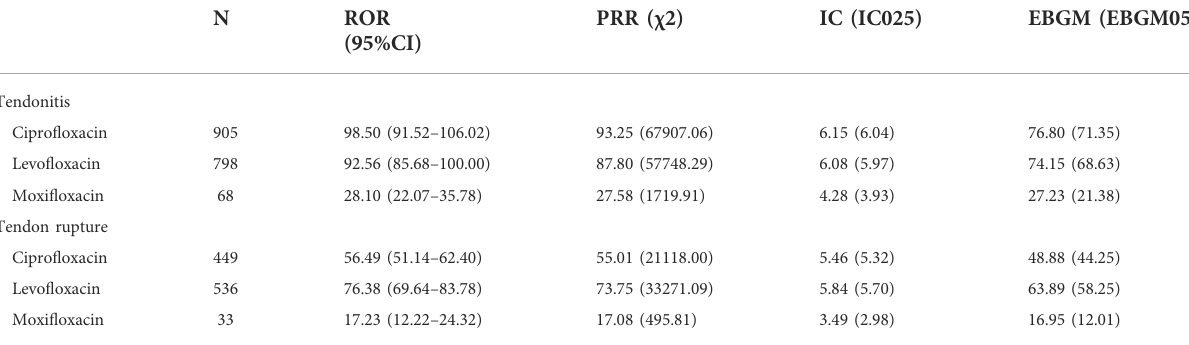
TABLE 2 Signal detection for cipro fl oxacin-, levo fl oxacin-, and moxi fl oxacin-associated tendonitis and tendon rupture.